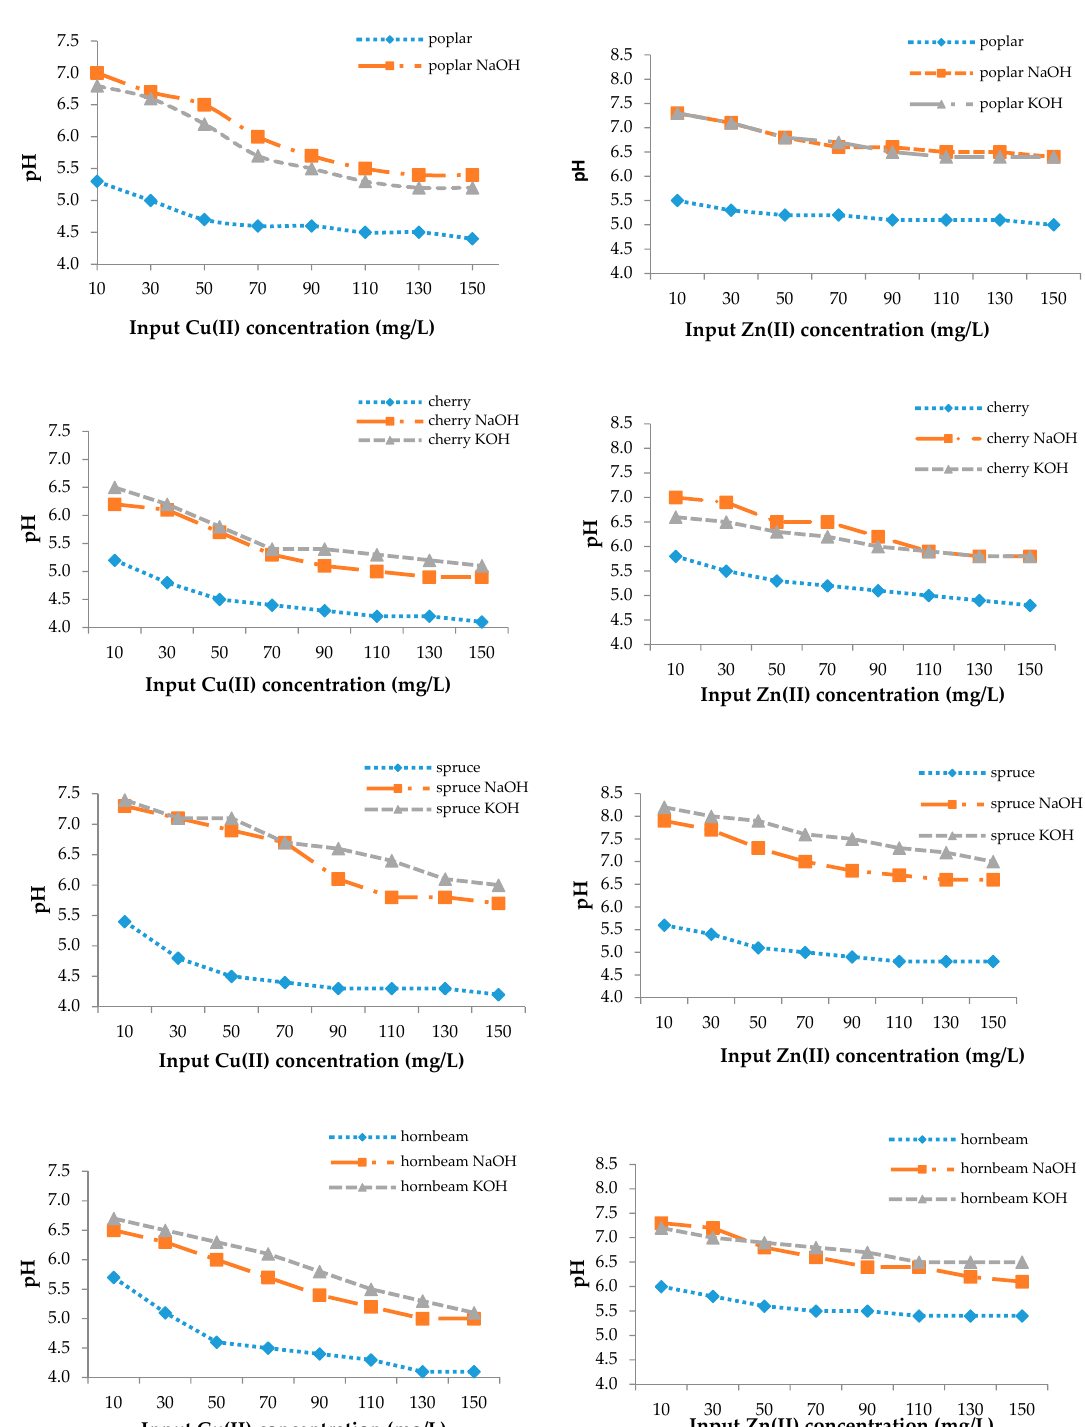
Figure 4. The final pH